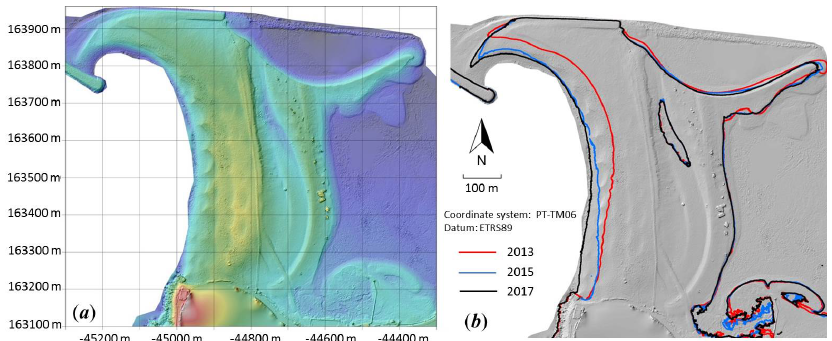
Figure 7. Differences in Cabedelo sandspit due to the sand movements: ( a ) colour coded DSM of 2017 and ( b ) hillshaded DSM with contours of the 2013 and 2015 DSMs overlaid.